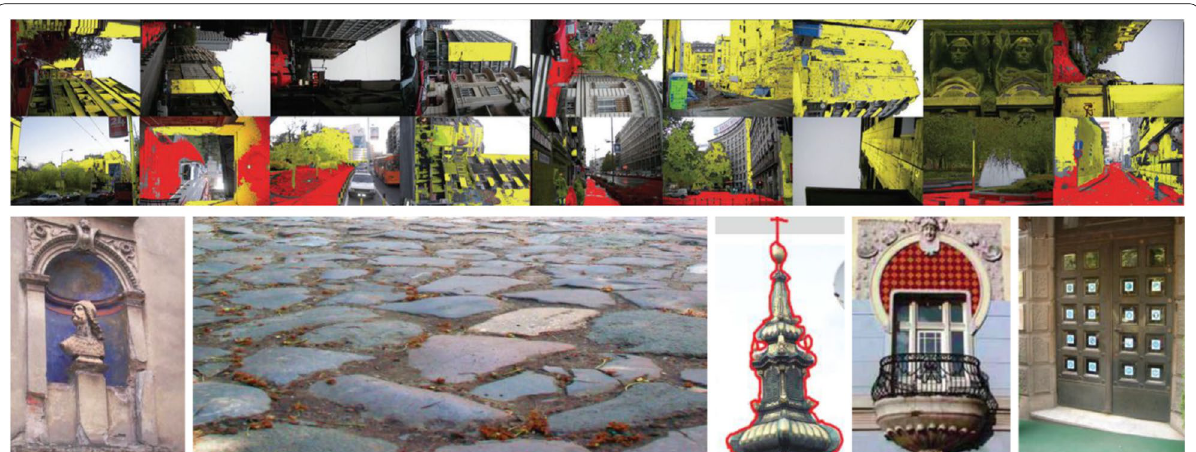
Fig. 12 Study of urban details in the Municipality Stari grad. From “Study of development of public spaces in the municipality of Stari Grad” by PaPs (2008)